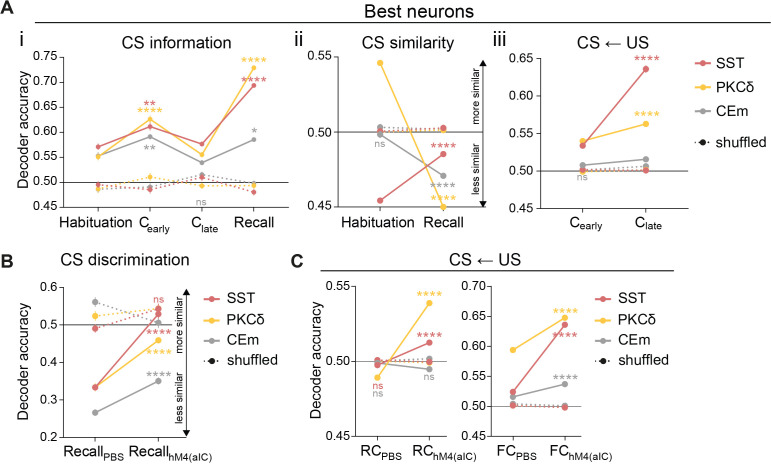
Valence-specific mapping of CS and US features in IC–CE circuitry.(A) Same decoding approach as in Figure 1D, using best neurons (see ‘Single-region decoding’ in Materials and methods) for (i) CS information (significant stage x population interaction in a two-way ANOVA, F15,9576=34.91, p<0.0001), (ii) CS similarity (significant stage x population interaction in a two-way ANOVA, F5,9588=311.70, p<0.0001) and (iii) the CS←US task (significant stage x population interaction in a two-way ANOVA, F5,9588=163.90, p<0.0001). (B) Alternative decoding approach for CS discrimination (as in Figure 1—figure supplement 7B), using best neurons in control conditions (PBS) and aIC inhibition (hM4(aIC)) at recall (significant treatment x population interaction in a two-way ANOVA, F5,2387=29.37, p<0.0001). (C) Projection of US properties by application of an MLP trained to detect US information in best neurons of CE populations under control conditions (PBS) and aIC inhibition (hM4(aIC)), applied to the respective CS (RC: significant treatment x population interaction in a two-way ANOVA, F5,4788=186.13, p<0.0001; FC: significant treatment x population interaction in a two-way ANOVA, F5,4788=195.10, p<0.0001). * Indicates significant differences between stages, within population. Holm-Sidak post hoc for all analyses, *p<0.05, **p<0.01, ***p<0.001, ****/####p<0.0001. All data presented as mean ± SEM. Full statistical report in Appendix 1—table 1.